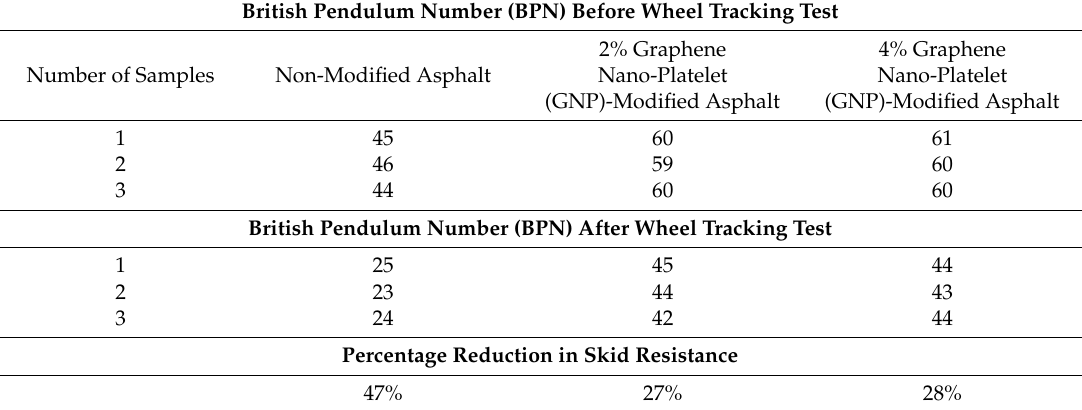
Table 8. The British Pendulum Numbers